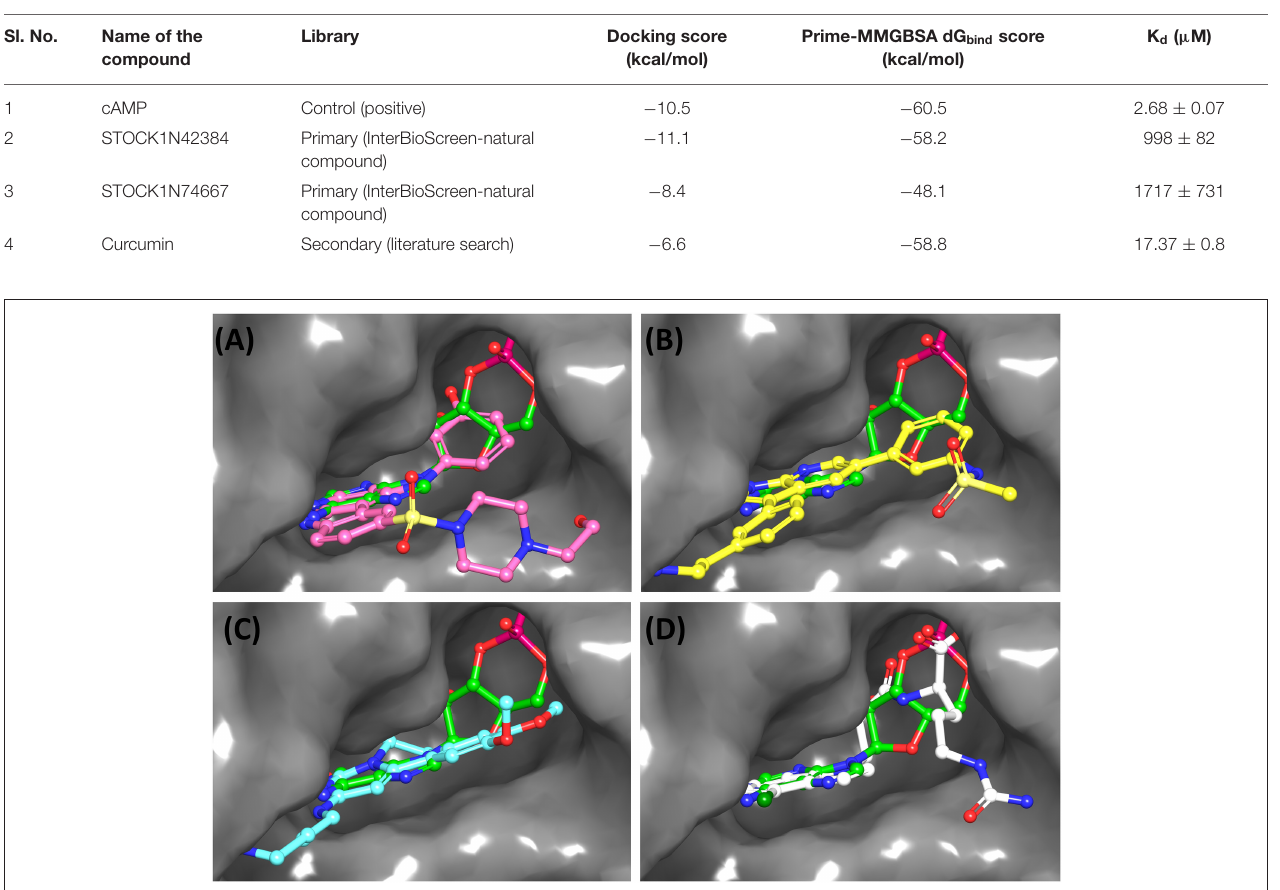
FIGURE 3 | Overlay of docked pose of selected compounds on to the bound pose of cAMP (green stick) as reported in 5AHW. The protein binding site is depicted as gray surface, and the ligands are shown in ball and stick representation: (A) ChEMBL3133832 (pink carbon), (B) ChEMBL2109743 (yellow carbon), (C) STOCK1N-42384 (cyan carbon), (D) STOCK1N-74667 (white carbon). Nitrogen, oxygen, chlorine, and sulfur atoms are shown in blue, red, dark green, and yellow, respectively. Hydrogen atoms were not displayed during image generation to maintain visual clarity.